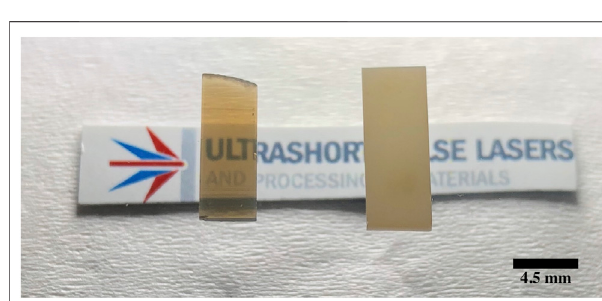
FIGURE 4 | Spatial propagating modes at 633 nm of the planar waveguide in the nc-YSZ ceramic after 24 h of annealing in air. (A) TE polarization single-mode propagation, (B) TE polarization multi-mode propagation. The inset pictures in this fi gure show the propagating modes prior to annealing.